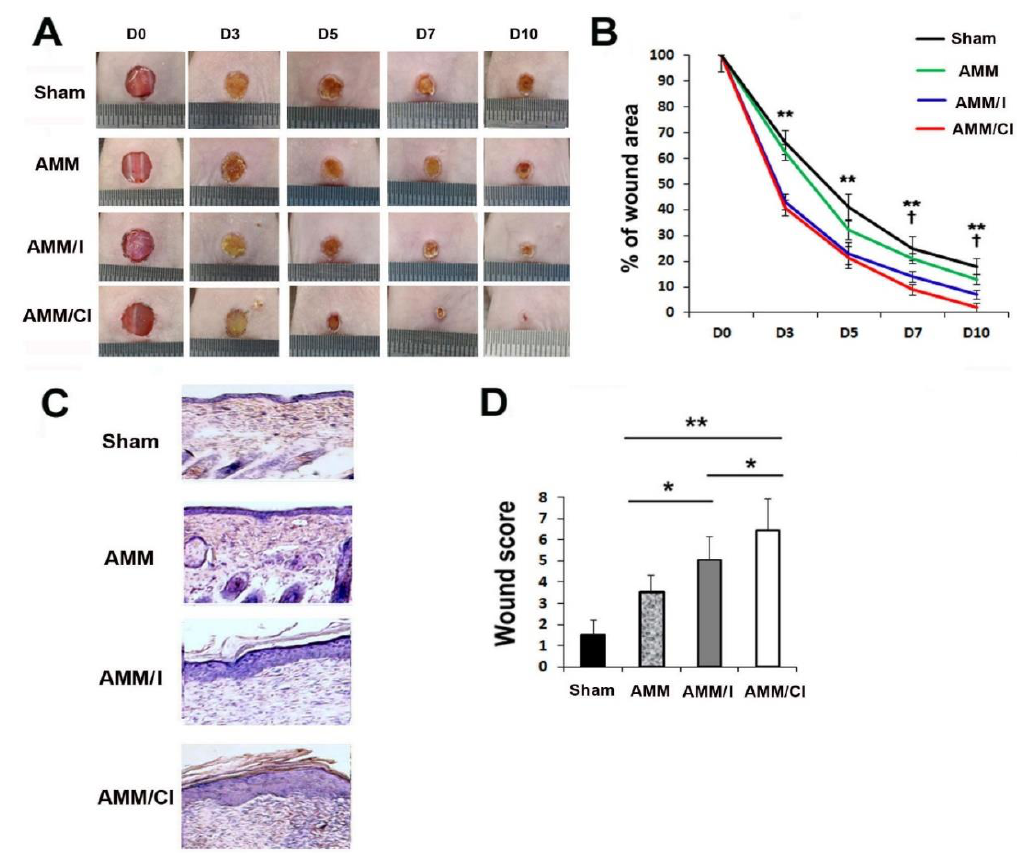
after cell injection. ( B ) Analysis of in vivo wound healing after cell injection. † p < 0.05, AMM/I vs. AMM/CI; ** p < 0.01, AMM vs. AMM/CI. n = 7 per group. ( C ) Representative wound histological pictures by H&E staining using cross‑sectioned wound tissues at 10 days after cell injection. ( D ) Analysis of wound histological scores. ** p < 0.01, * p < 0.05, n = 7 per group.